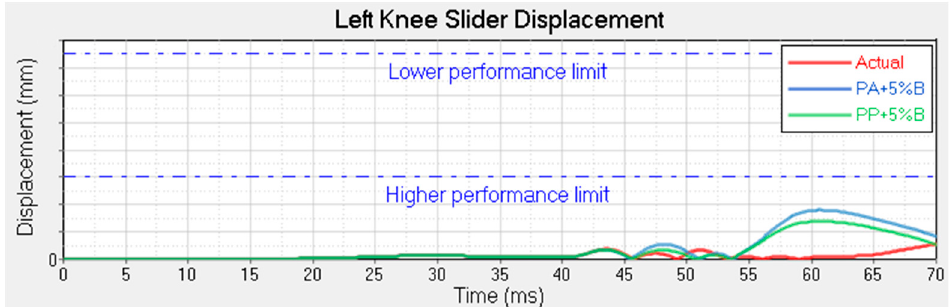
Figure 10. Left knee slider displacement.